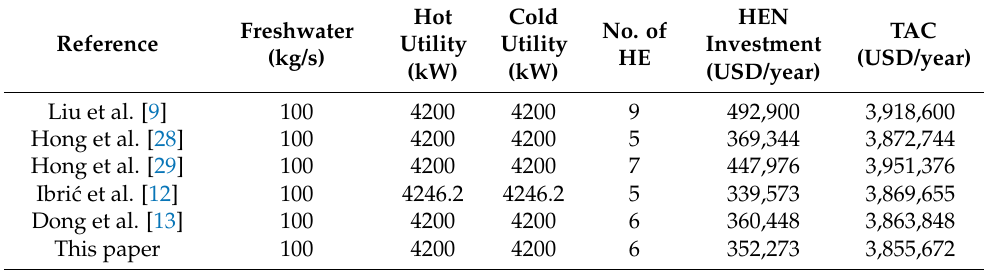
Table 10. Comparison of the results with those from the literature for Example 5.